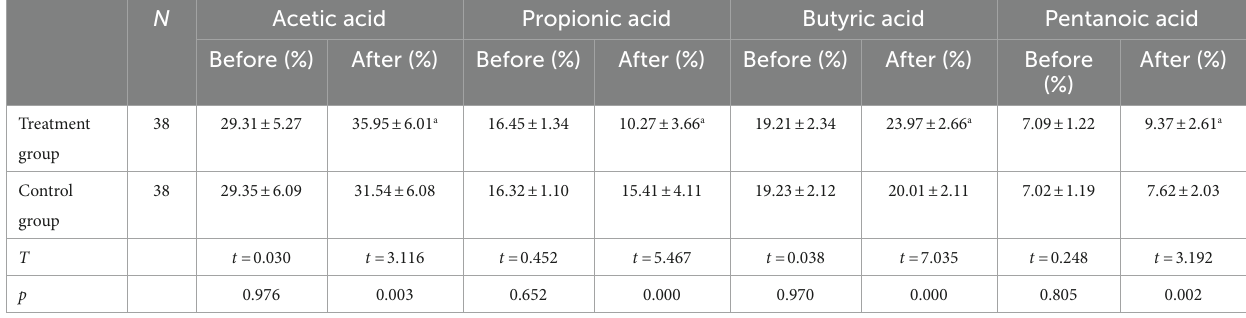
TABLE 3 The data before and after the TMS treatment of the different studied variables (Serum Nutritional Indexes). Group N Before c Before After Before After